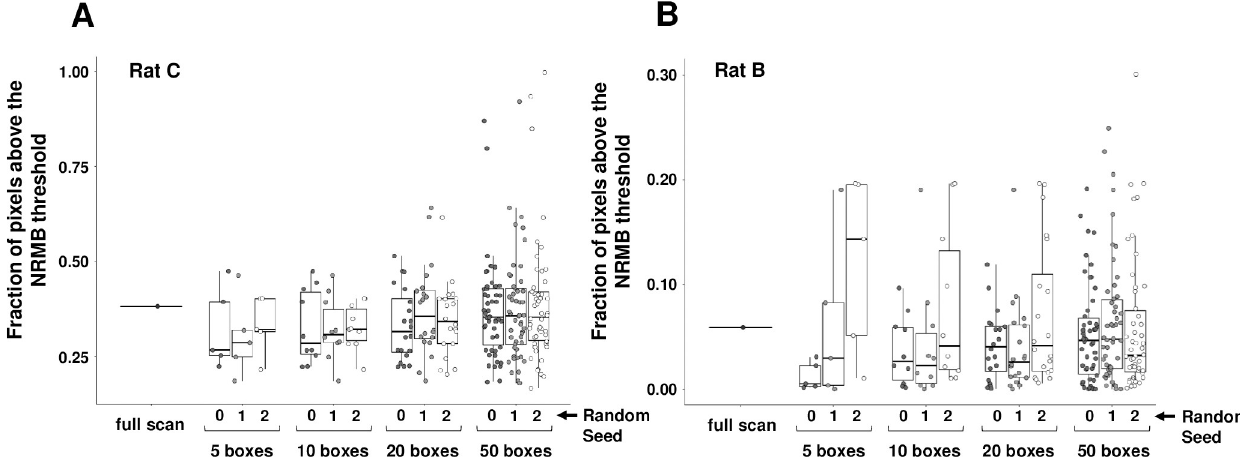
Fig 4. Reproducibility of the fraction of pixels deemed DAB stained improves with an increasing number of sampling boxes. Random sampling with the indicated number of boxes per slide was repeated using each of 3 different randomization seeds to test reproducibility in each of 2 different slides.